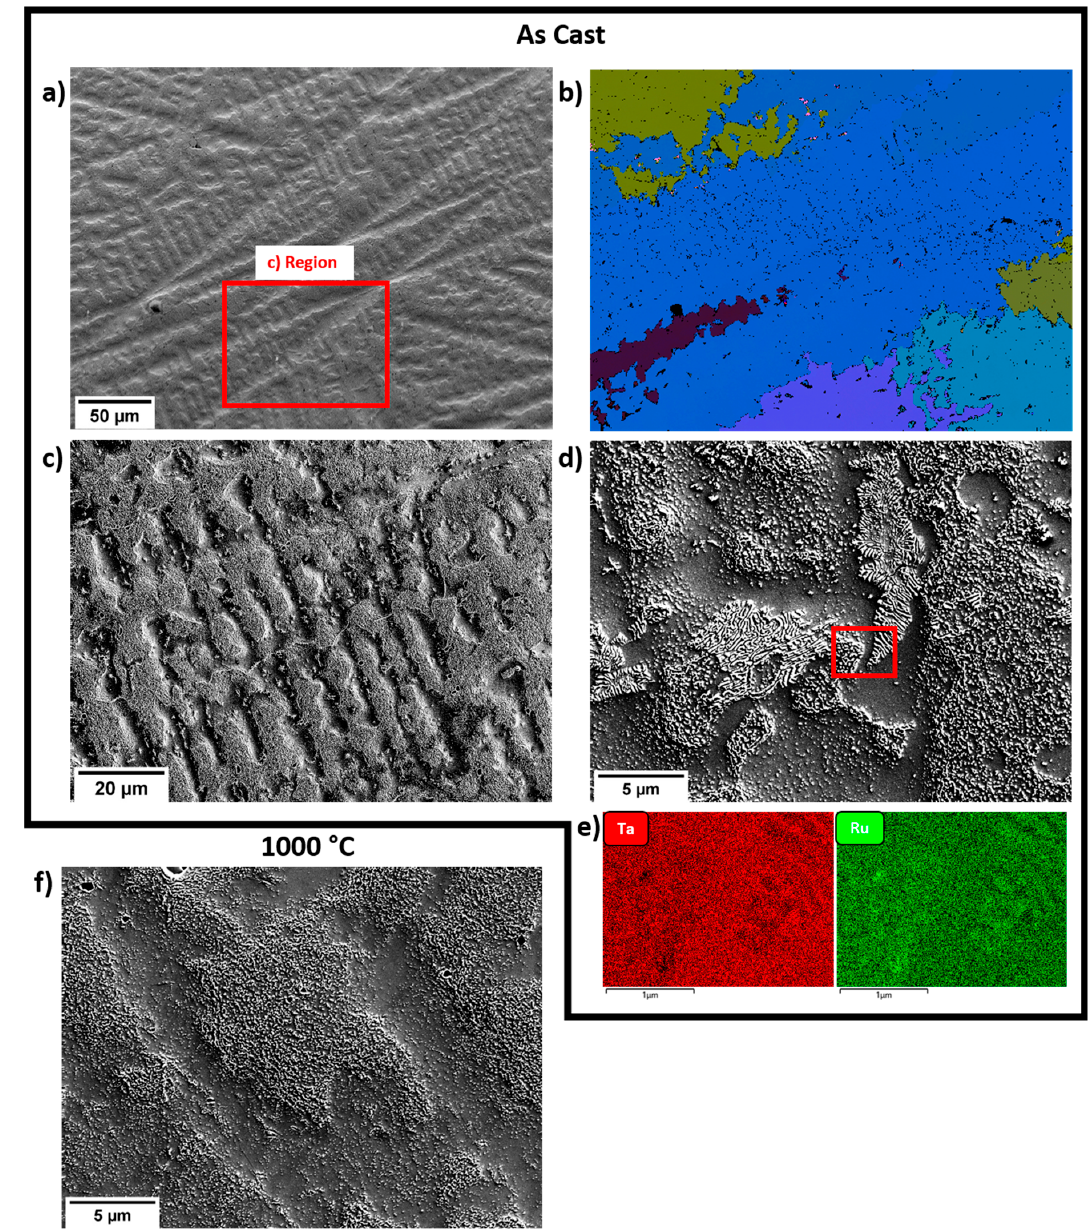
Figure 2. ( a ) 20 kV Secondary electron SEM micrograph of the as cast Ta72Ru28 alloy and ( b ) corre- sponding EBSD euler map. All points were indexed as BCC. ( c – d ) show higher resolution secondary electron images of the as cast alloy. ( e ) Low voltage (5 keV) EDX maps from the red box in ( d ) showing qualitatively more Ru in the white regions. ( f ) Secondary electron SEM micrograph of the aged Ta72Ru28 alloys, showing the similar distribution of regions as the as cast alloy.